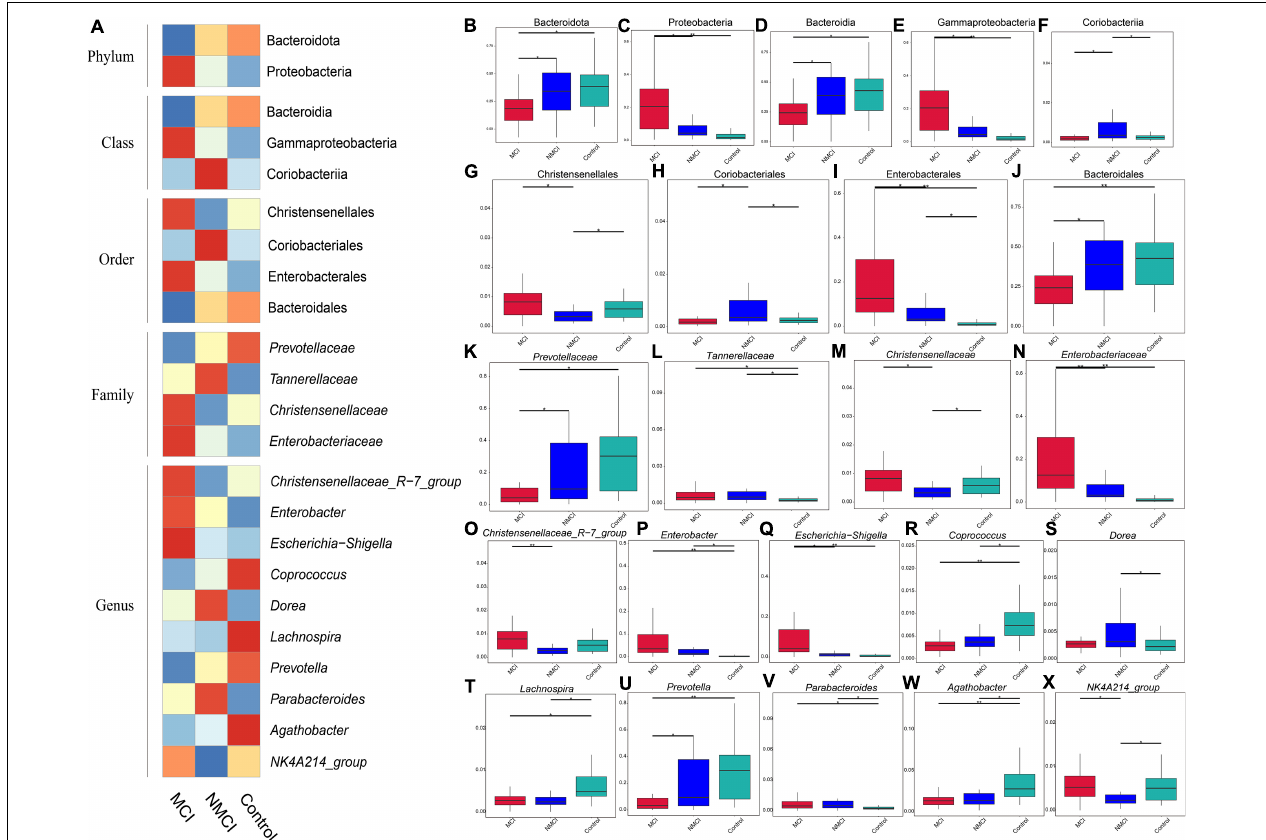
FIGURE 2 | Differences in the abundance of intestinal flora. MetaStat analysis was performed to compare the relative abundance differences of intestinal flora. (A) Heatmap of relative abundance difference. (B,C) Phylum level. (D–F) Class level. (G–J) Order level. (K–N) Family level. (O–X) Genus level. MCI, hypertension patients with cognitive impairment; NMCI, hypertension patients without cognitive impairment; Control, health control subjects.